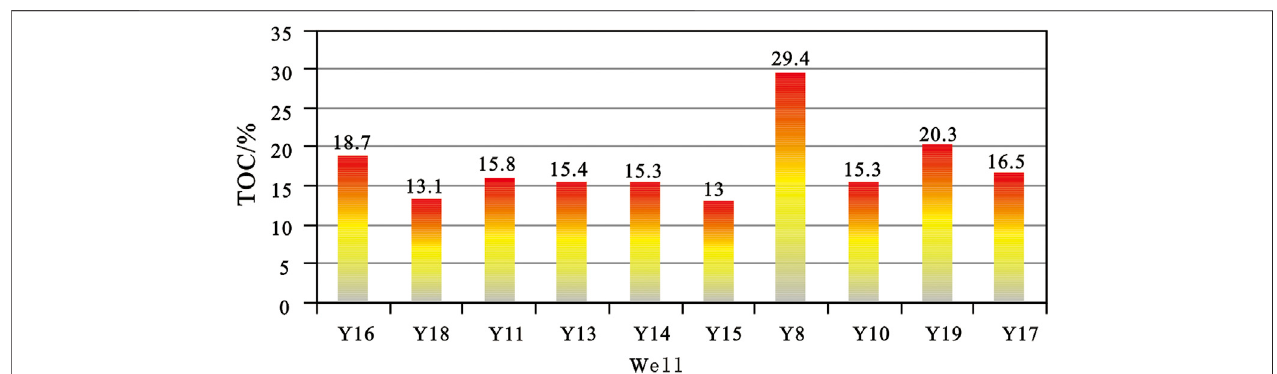
FIGURE 5 | TOC distribution histogram of the Leping Formation carbonaceous shale in the study area.